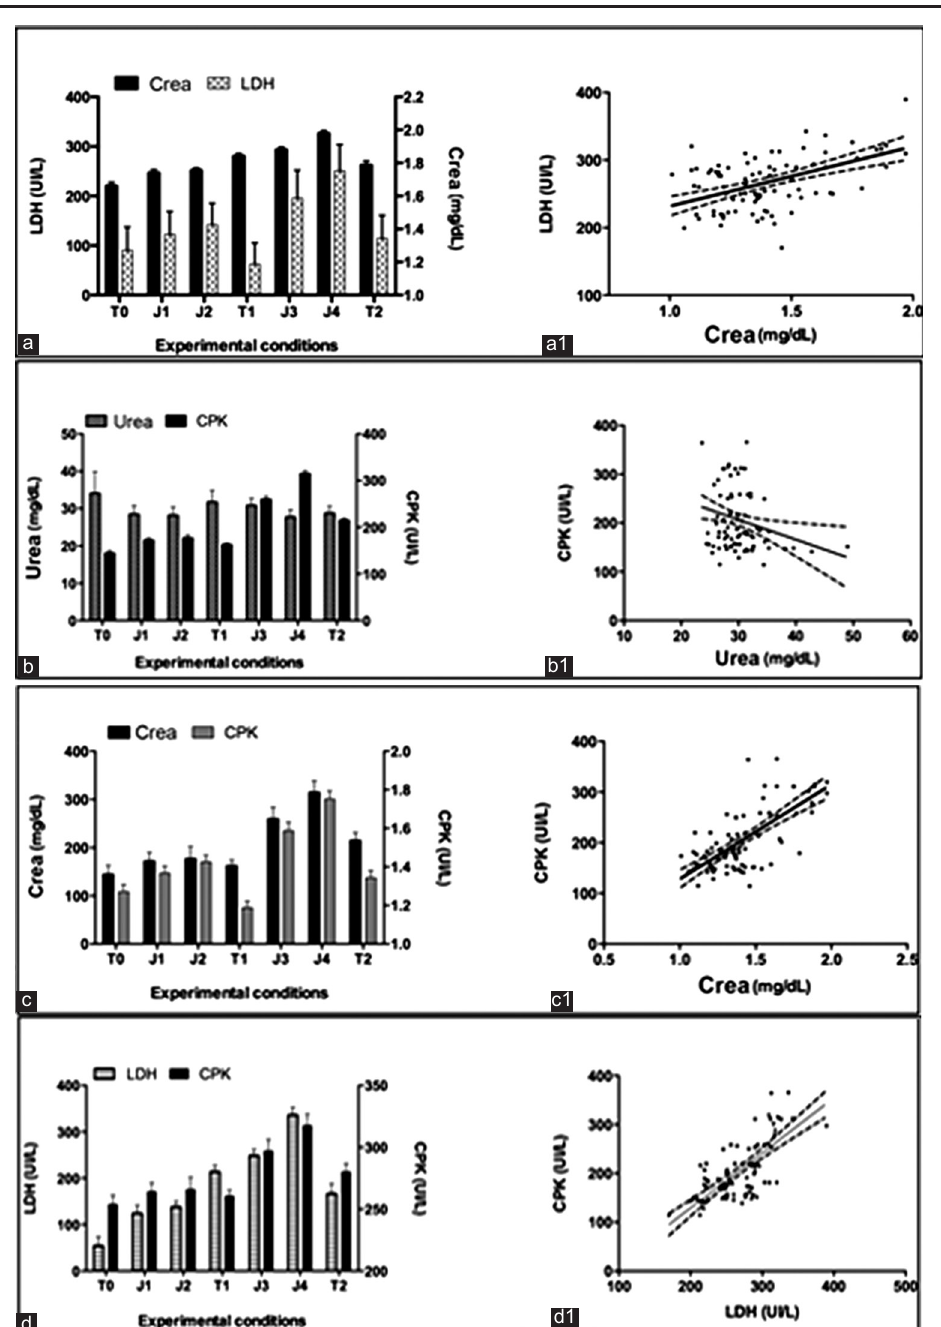
Figure-1: (a) Pattern of serum creatinine (CREA) and lactic dehydrogenase (LDH) observed during experimental period; (a1) Graphical representation of simple linear regression of LDH vs. CREA; (b) Pattern of CREA and creatine phosphokinase (CPK) observed during experimental period; (b1) Graphical representation of simple linear regression of CPK versus CREA, (c) Pattern of serum urea and CPK observed during experimental period; (c1) Graphical representation of simple linear regression of CPK versus urea; (d) Pattern of LDH and CPK observed during experimental period; (d1) graphical representation of simple linear regression of CPK versus